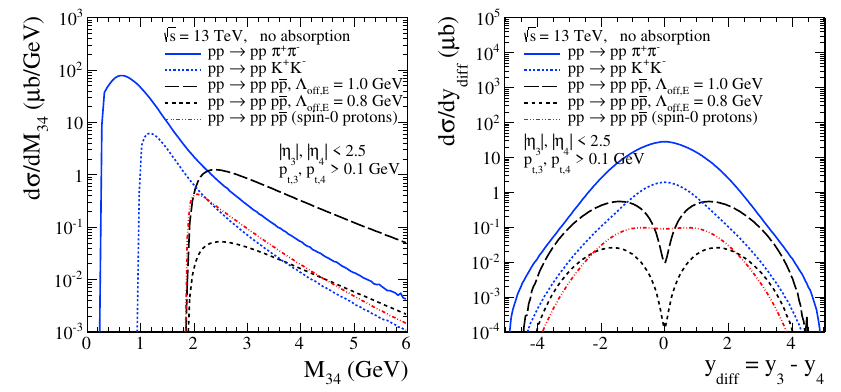
Figure 5. In the left panel we show the invariant mass distributions for centrally produced π + π − , K + K − √ s = 13 TeV. Results for the combined and p ¯ p systems for a typical LHC experimental conditions at tensor-pomeron and reggeon exchanges and Λ of f , E = 1 GeV are presented. For the p ¯ p production we show results also for Λ of f , E = 0 . 8 GeV. In the right panel we show the distributions in the rapidity di ff erence between the centrally produced hadrons. No absorption e ff ects were included here.